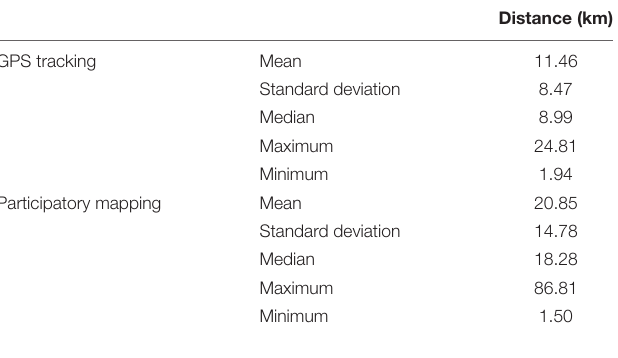
TABLE 2 | Dataset summary of distances with GPS tracking and participatory